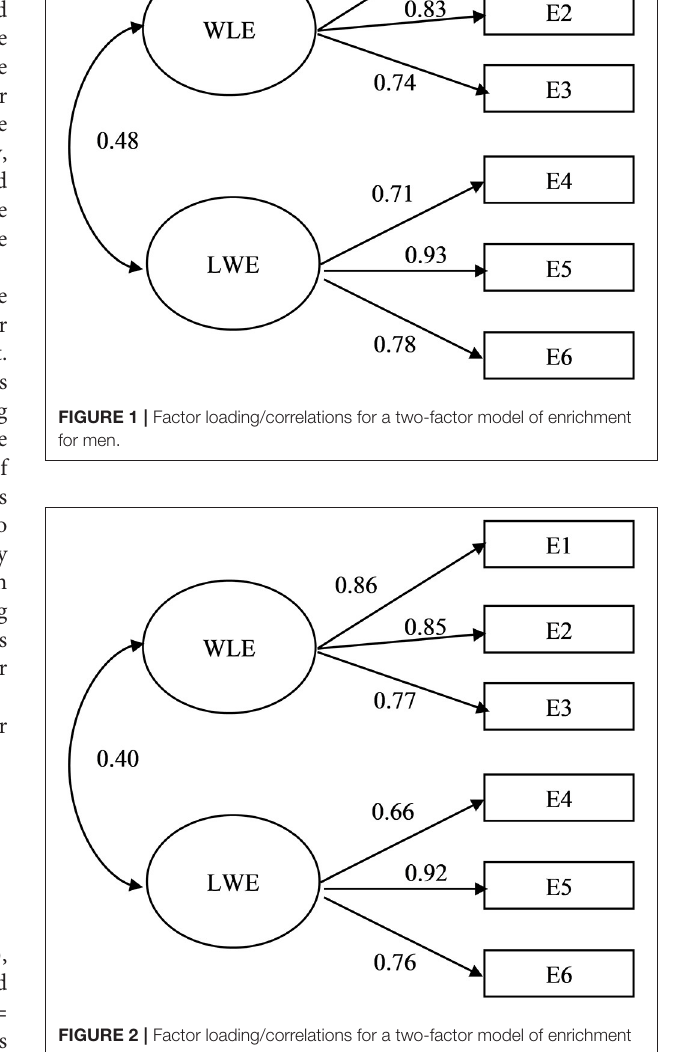
women (0.40). A reliability test showed high internal consistency for the respective factors and respective gender: WLE (Cronbach’s alpha = 0.83 for men and Cronbach’s alpha = 0.85 for women) and LWE (Cronbach’s alpha = 0.84 for men and Cronbach’s alpha = 0.81 for